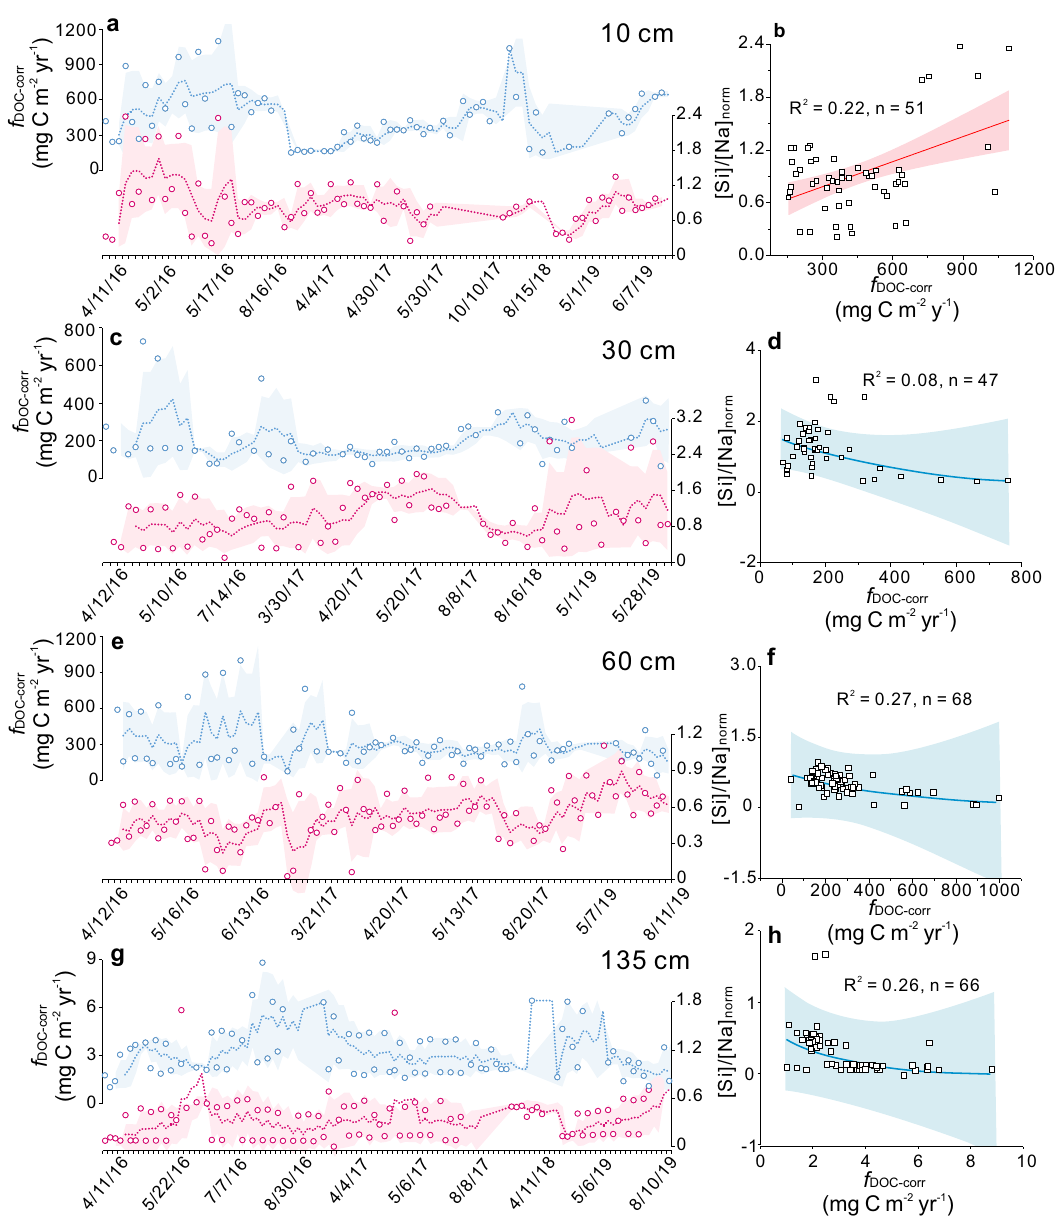
Fig. 6 | Relationships between dissolved organic carbon (DOC) fl uxes and weathering congruency at the four depths. Corrected DOC fl uxes ( f DOC-corr ) and normalized Si concentration/Na concentration ([Si]/[Na] norm ) show positive cov- ariation in the topsoil ( a , b ) but negative covariation below the topsoil ( c – h ).